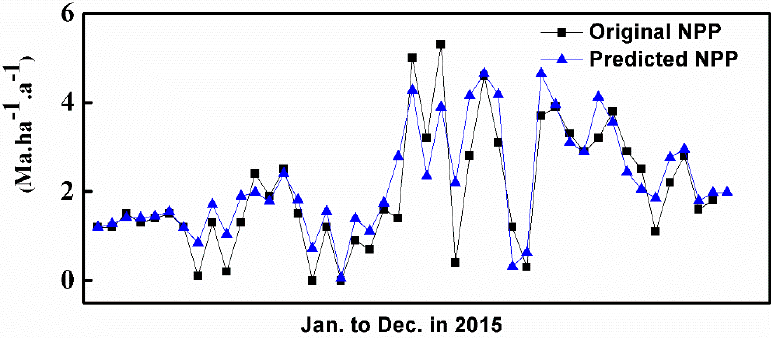
Figure 7. Comparison of original MODIS-NPP data from MOD17 and predicted data for Schima in 2015.